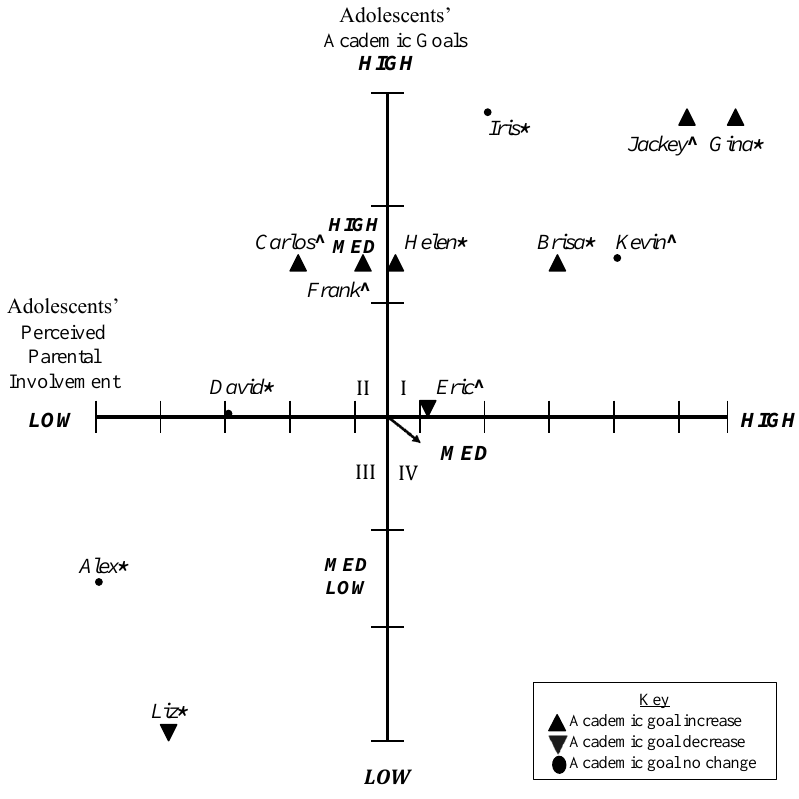
Figure 4. Adolescents’ perceived parental involvement and academic goals post-program. Adolescent’s grade level: * = middle school; ˆ = high school. Quadrant I, seven adolescents reported medium to high parental involvement and reported medium to high academic goals. Quadrant II, three adolescents reported low to medium parental involvement and reported medium to high academic goals. Quadrant III, two adolescents reported low to medium parental involvement and reported low to medium academic goals. Quadrant IV, none of the adolescents reported medium to high parental involvement or low to medium academic